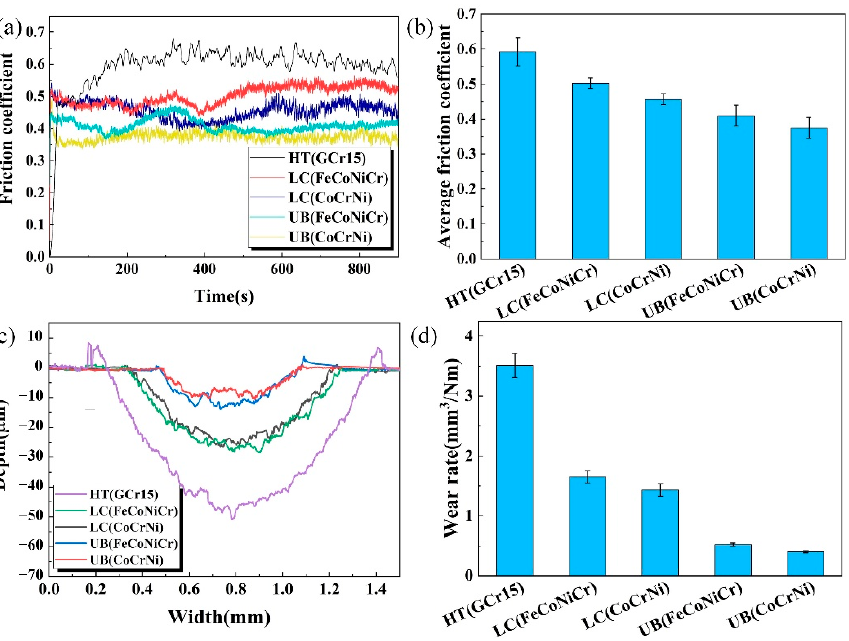
Figure 11. Friction test results. ( a ) Friction coefficient variations; ( b ) average friction coefficient; ( c ) wear profile curve of the cross-section; ( d ) wear rates of samples.